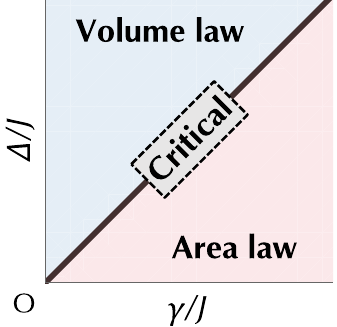
FIG. 7. Phase diagram of the symplectic Hatano-Nelson